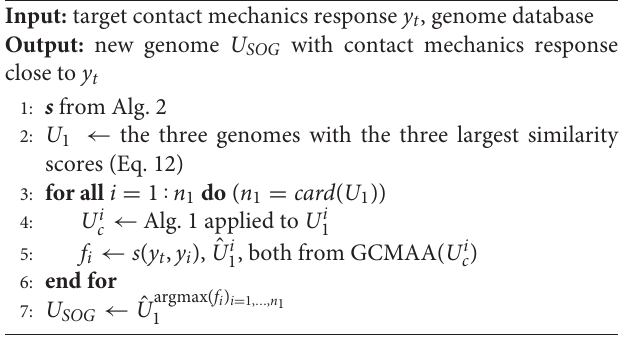
Algorithm 3 | Simple Optimization of Genes